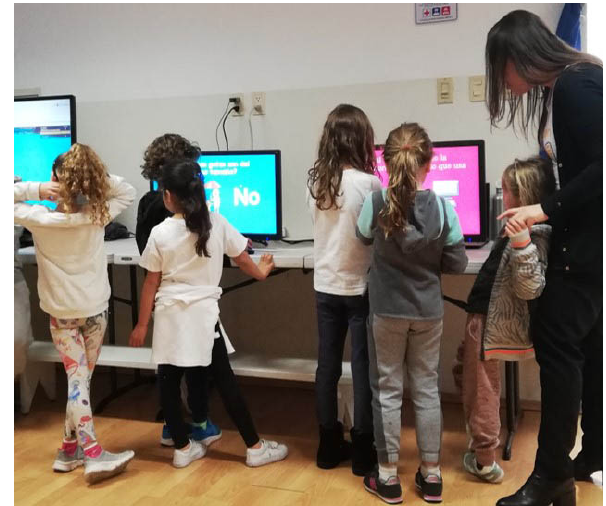
Figure 9. A group of students playing the water and technology quiz during one of the